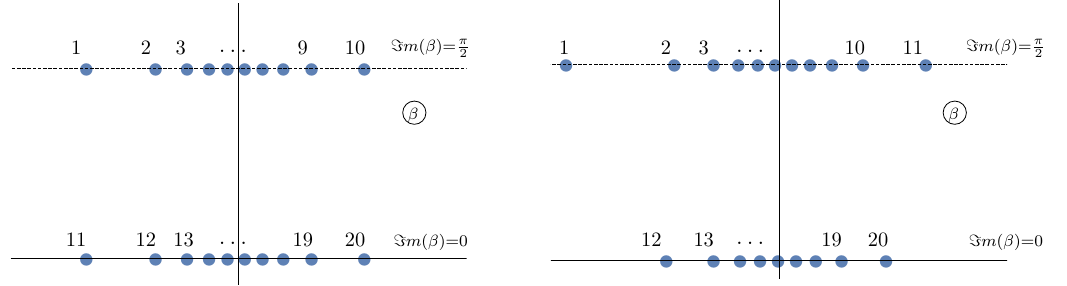
Figure 4. The pattern of Bethe roots in the complex plane for L = 20, (cid:13) = (cid:25) , k = 1 and with 5 10 S z = 0. The integers beside each point show the labeling of the roots (cid:12) j . The corresponding Bethe numbers are given by eq. (16). The left panel corresponds to the ground state for which the number of roots on the lines = m ( (cid:12) ) = 0 and (cid:25) are equal ( m = 0); whereas on the right panel there are two 2 more roots on the upper line than the lower one, i.e., m =